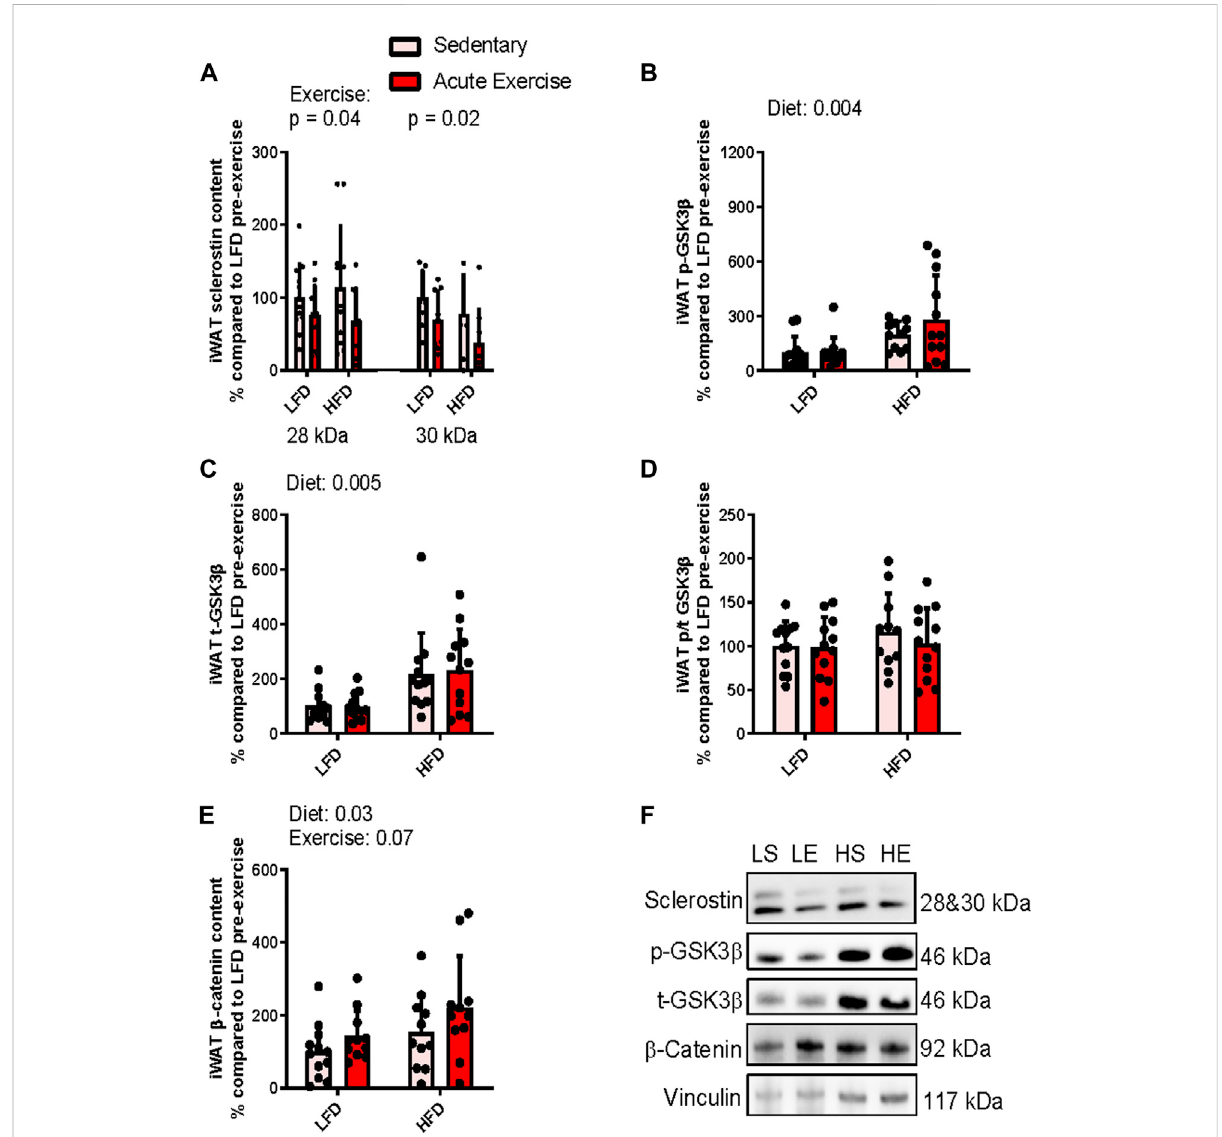
FIGURE 2 Response of iWAT sclerostin content (A) , serine9 phosphorylation status (B,D) both total GSK3b content (C) , and total b-catenin content (E) to HFD and acute exercise, as well as representative immunoblots (F) . Light grey bars represent sedentary mice and dark grey bars represent mice sampled 2 hfollowing 2 h of acute enduranceexercise and are grouped by diet; LFD = low fat diet; HFD = high fat diet. Proteins are corrected for by thehousekeeping protein vinculinand are all relative to LFD sedentary mice, data are presented as means ± SD and main effects are presented ongraphsonlyiftheyareeither closetooraresigni fi cant.A two-wayfactorialANOVA wasused toexaminemaineffectsfordietandexerciseas well their interaction. Tukey correction was used for multiple pairwise